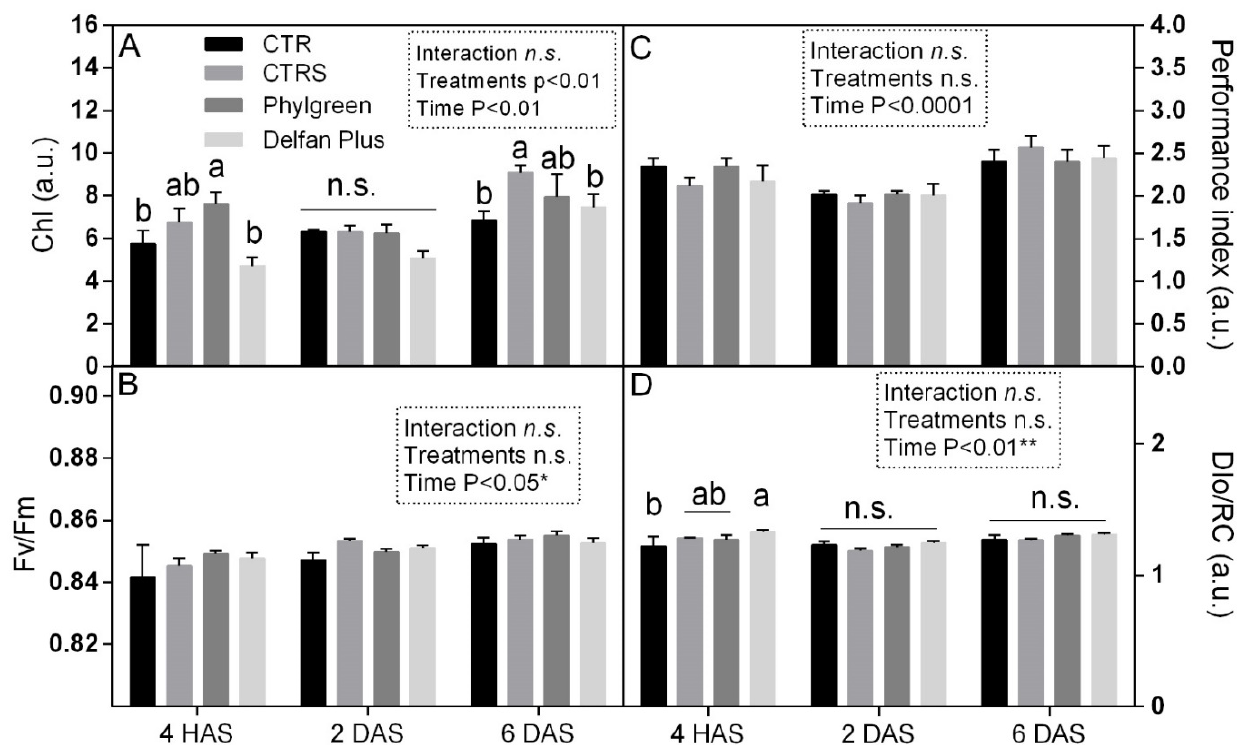
Figure 6. Non-destructive chlorophyll content ( A ), Fv/Fm ratio ( B ), performance index ( C ), and DIo/RC ( D ) measured in Arabidopsis thaliana plants treated in CTR, CTRS, Phylgreen, and Delfan Plus in 3 different moments (4 HAS, 2 and 6 DAS). Data are means with standard errors ( n = 5). Statistical analysis was performed using two-way ANOVA and differences amongst means were determined using LSD test. Asterisks indicate significant differences, * for p < 0.05, ** for p < 0.01. In the A and D, significant differences for each timepoint have been highlighted using different letters.